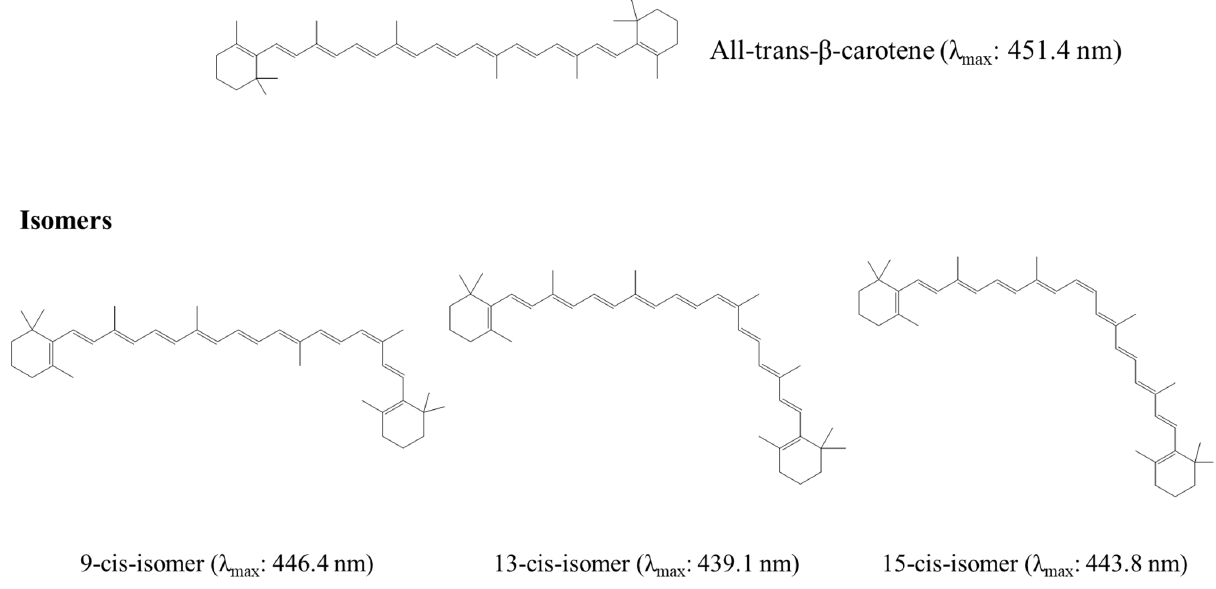
Figure 2. The structures of E ( trans )- and Z ( cis )- forms of β -carotene.